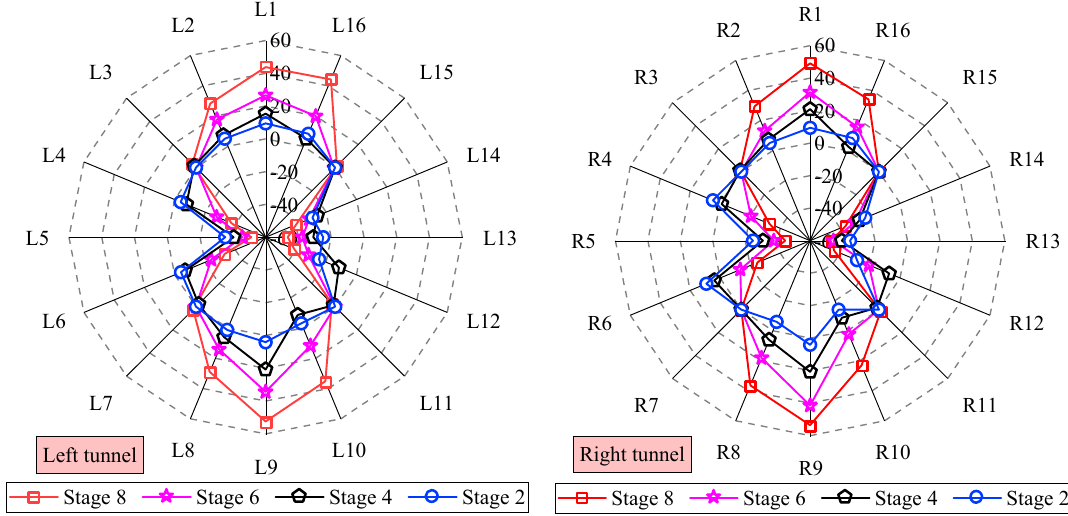
Figure 11. Variation of bending moment with excavation stage (unit: kN·m).